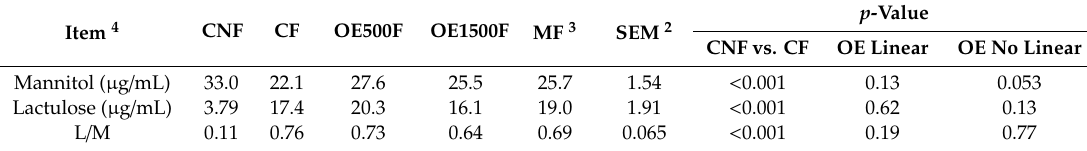
Table 4. E ff ect of a short-term (15.5 h) fasting period and experimental diets on lactulose, mannitol and lactulose / mannitol ratio in chicken plasma at 15 d of age 1